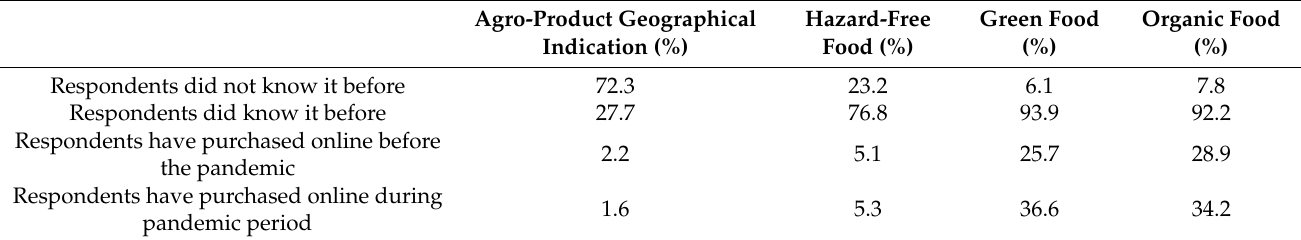
Table 4. Respondents’ familiarity and their online purchase experience of different Chinese certified food